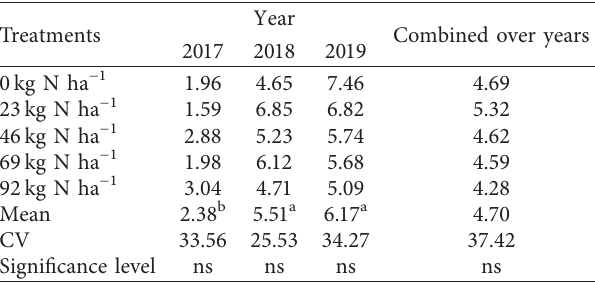
Table 3: Mean forage DM yield (t ha − 1 ) of Chloris gayana grass in response to different N fertilizer levels.